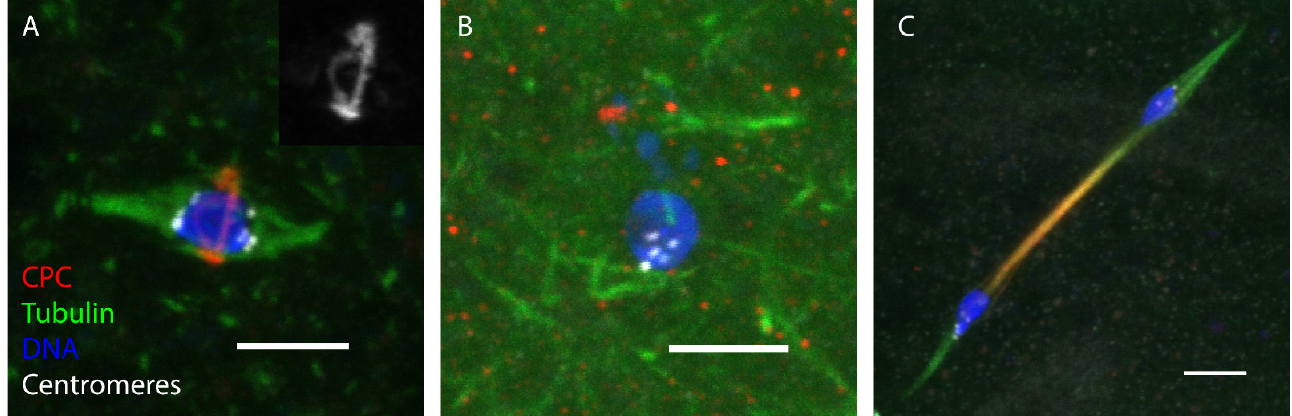
Figure 2. The latest stage, meiotic metaphase. In stages 13–14, the nuclear envelope breaks down and the meiotic spindle assembles. Meiosis arrests in metaphase I and progresses into anaphase I and meiosis II only when the oocyte passes through the oviduct on the way to being fertilized. In all images, the spindle is in green, the chromosome passenger complex (CPC) in red, centromeres in white, DNA in blue, and the scale bar is 5 µm. ( A ) A metaphase I spindle in a stage 14 oocyte. The inset shows that the central spindle proteins are organized in a microtubule-associated ring that goes around the chromosomes and is perpendicular to the spindle. ( B ) The CPC is required for spindle assembly. An oocyte expressing an shRNA for RNAi against INCENP causes the loss of all spindle microtubules. ( C ) In the absence of chiasma and tension, precocious anaphase is observed. This is an oocyte homozygous for a mei-P22 mutation, which eliminates all meiotic recombination.